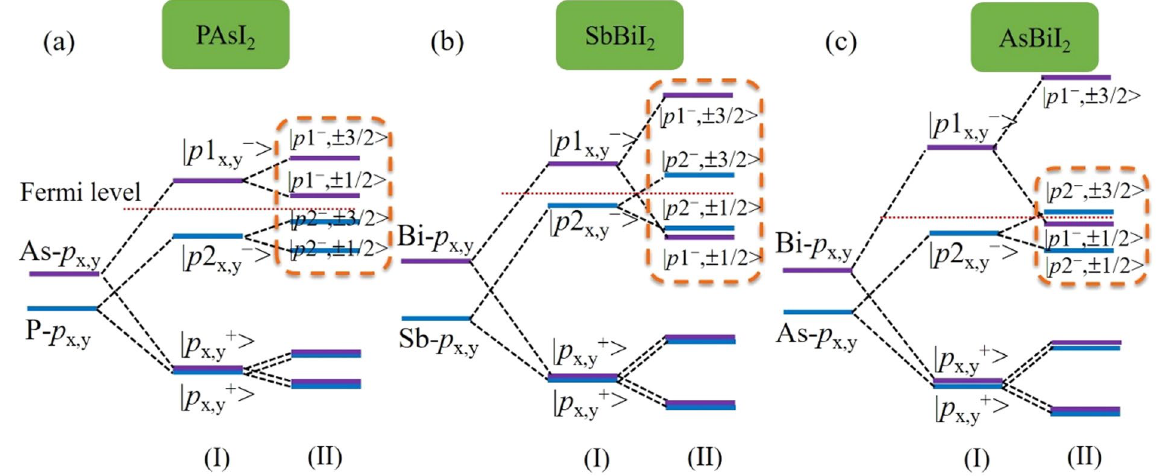
Figure 4. The evolution of p x,y orbitals of A and B atoms at K point near the Fermi level under chemical bonding (I) and SOC (II) effects. ( a ) PAsI 2 , ( b ) SbBiI 2 , and ( c ) AsBiI 2